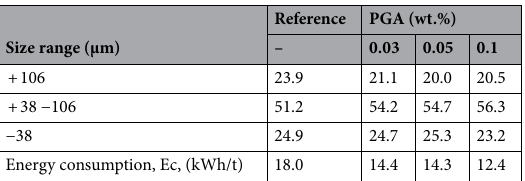
Table 2. Summary of the grinding test with and without PGA (Ec expressed as work index).